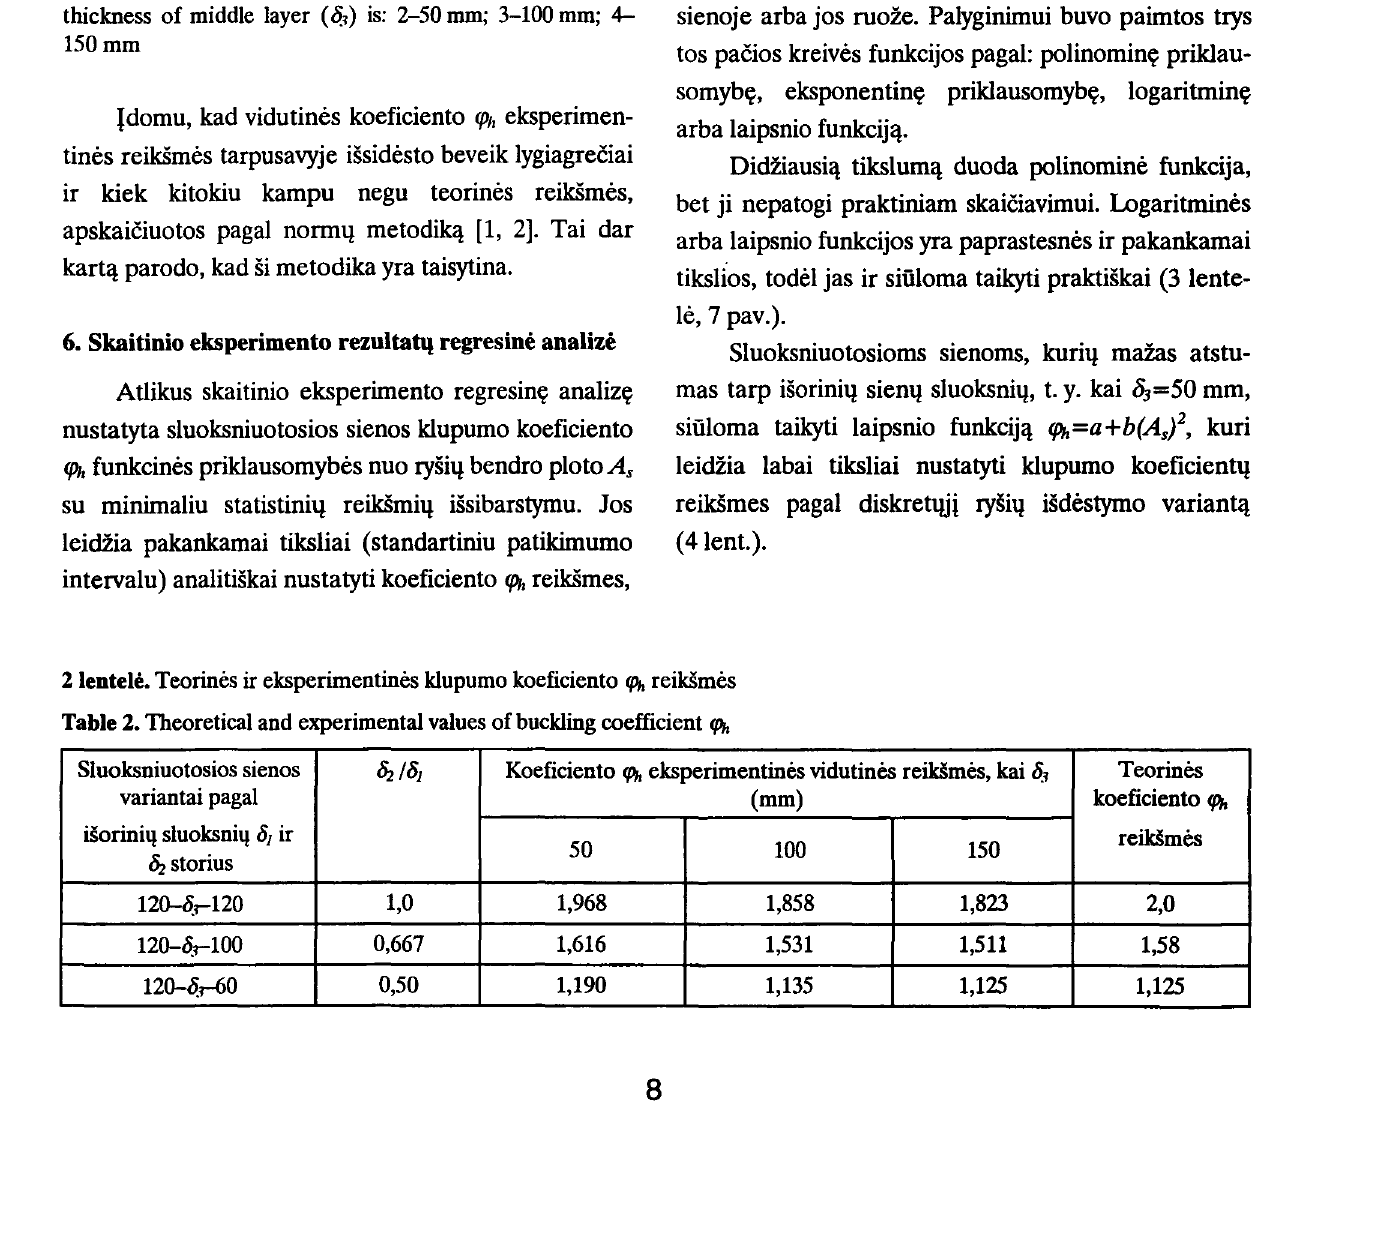
Fig 6. Relationship between theoretical ( 1) and experi mental (2, 3, 4) values of buckling coefficients rp,. and ratio of moments of inertia (thickness) of wall layers when thickness of middle layer ( ~l) is: 2-50 mm; 3-100 mm; 4- 150mm